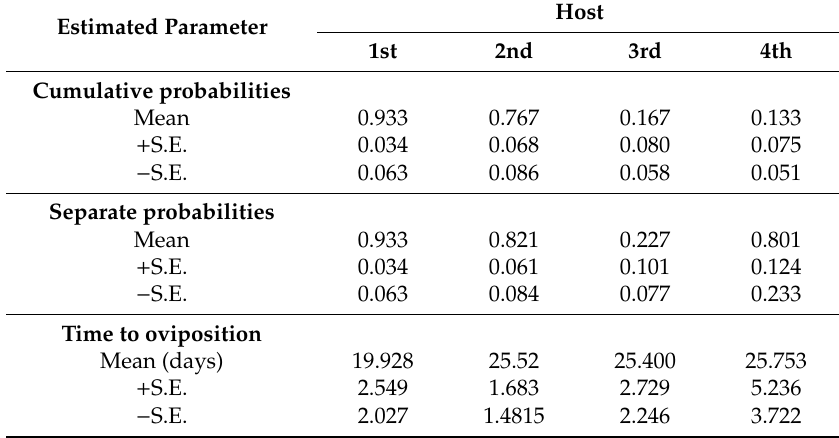
Table 1. Probabilities and timing of oviposition on successive hosts by groups of Sclerodermus brevicornis